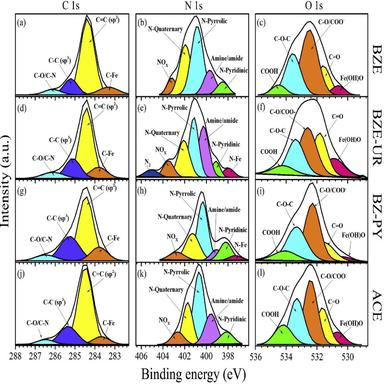
Deconvoluted high-resolution XPS spectra for the C1s, N1s, and O1s core level. Gaussian curves to fit the peaks. The results for the sample BZE (a-c), sample BZE-UR (d-f), sample BZ-PY (g-i), and sample ACE (j-l). Most carbon found is attributed to C¼C bonds (sp2 hybridization). N1s and O1s peaks exhibited remarkable modifications for different N-CFSs. displays the integrated area under each curve (estimation of the percentage of different chemical species involved at the surface of the N-CFS).